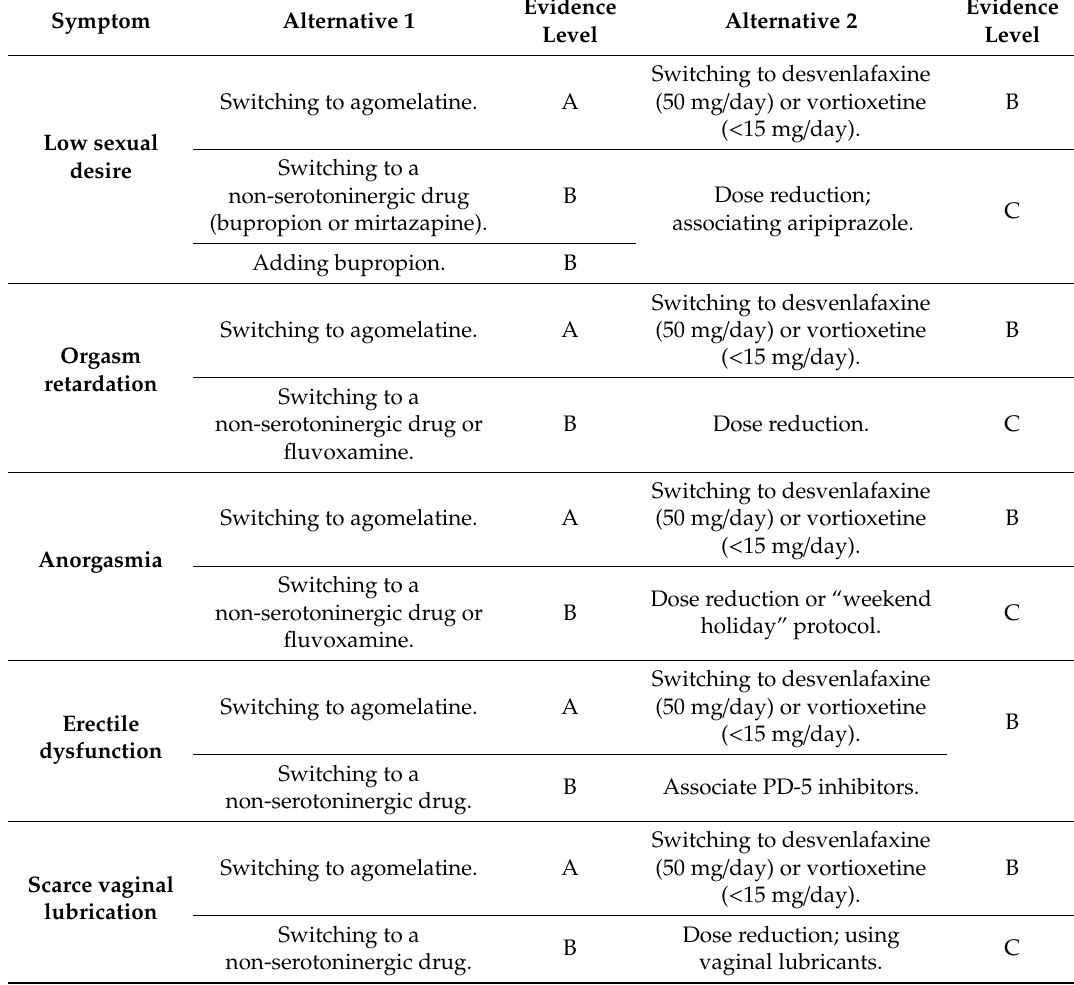
Table 4. Clinical recommendations for alleviating TESD based on scientific evidence levels * [42,50,56,